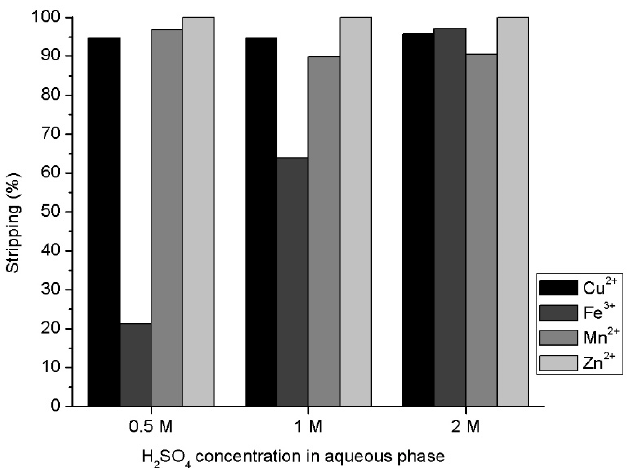
Figure 4. Effect of sulfuric acid on the stripping percentage of metals from the loaded organic phases. Experimental conditions: [R 4 NCy] = 0.54 M, O/A = 1, 400 min − 1 , and 20 min of stirring time.